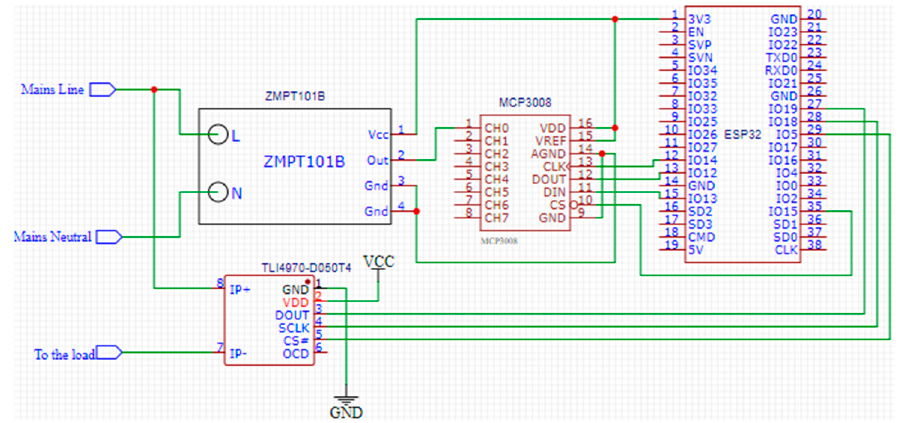
Figure 3. PCB schematic of the proposed smart PQ meter.